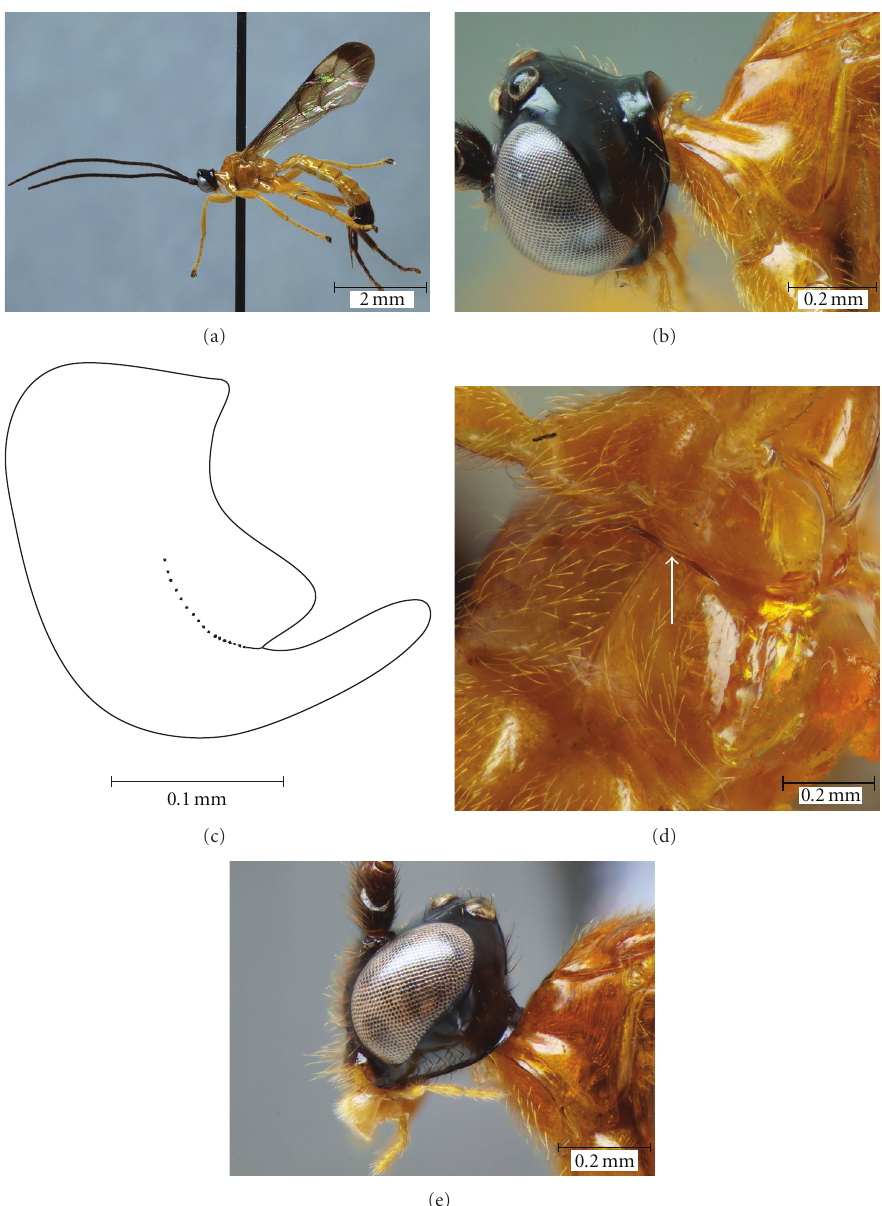
Figure 4: T. soinii sp.n.: holotype female habitus (a), occiput detail (b), fore tarsal claw (c), ventral view of epicnemium (d), and paratype male occiput detail